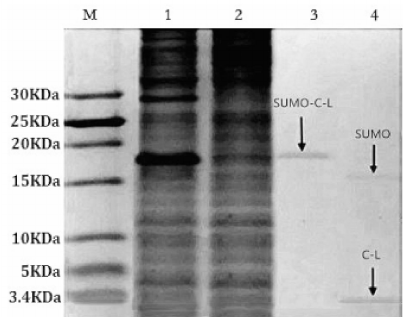
Figure 3. Tricine-SDS-PAGE analysis of purified fusion protein SUMO–C–L. Lane M, the molecular weight of marker; Lane 1, the supernatant of IPTG-induced E. coli BL21 (DE3); Lane 2, the supernatant of non-induced bacterial lysate; Lane 3, the purified fusion protein SUMO–C–L, arrow in the lane indicated the fusion protein SUMO–C–L; Lane 4, the enzymatic reaction solution of fusion protein, arrows in the lane were SUMO and recombinant